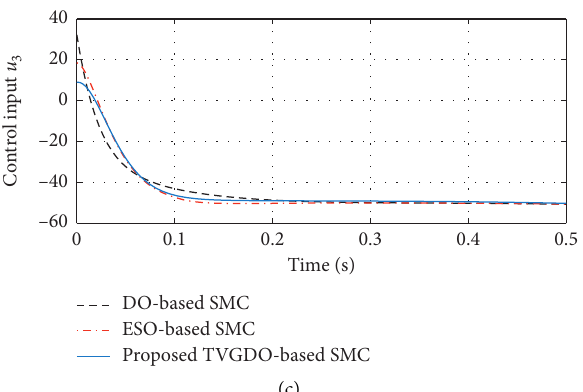
Figure 4: Control input (Case 1).